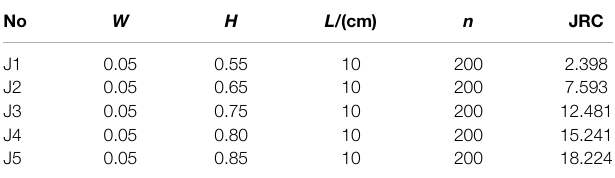
TABLE 1 | Rock joint pro fi le parameters with random morphology.